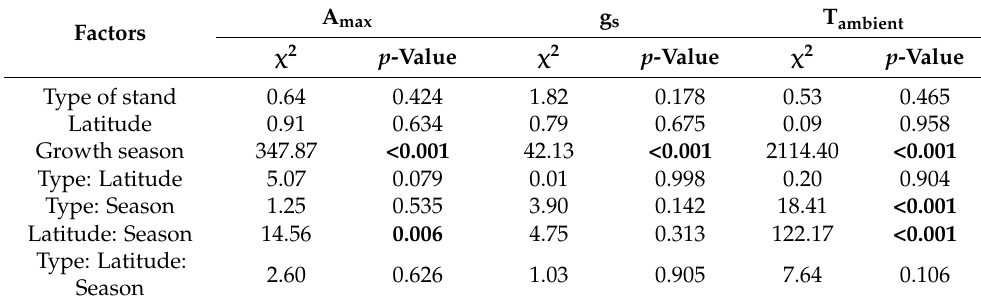
Table 3. Summary of ANOVA result (chi-square and p -value) of maximum photosynthetic rates (A max ), water vapor stomatal conductance (gs), and ambient temperature at the time of measurement (Tambient). Bold p -value indicates significant difference at the 5% threshold. A max g Factors